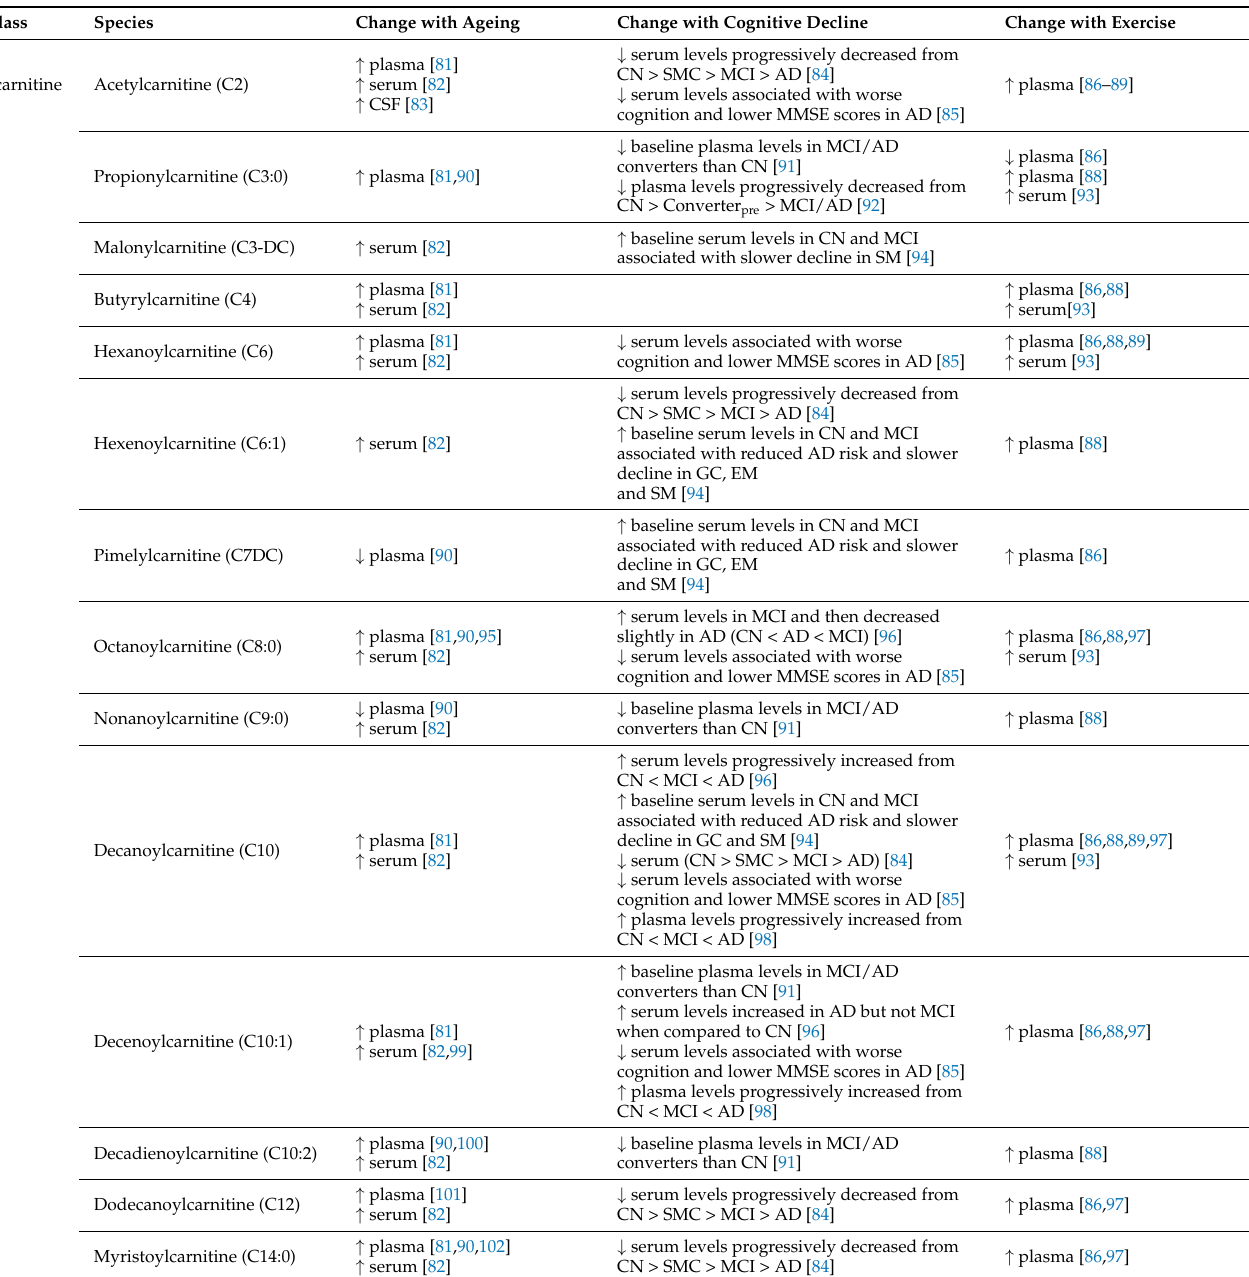
Table 1. Changes in fatty acyls with ageing, cognitive decline and exercise in